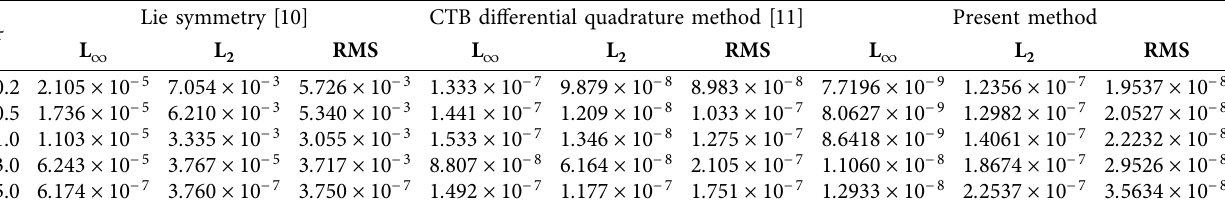
Table 3: Comparison of L , L , and RMS error norms of present method with [10, 11] for Example 2 at diferent τ and fxed δ � 1 . ∞ 2